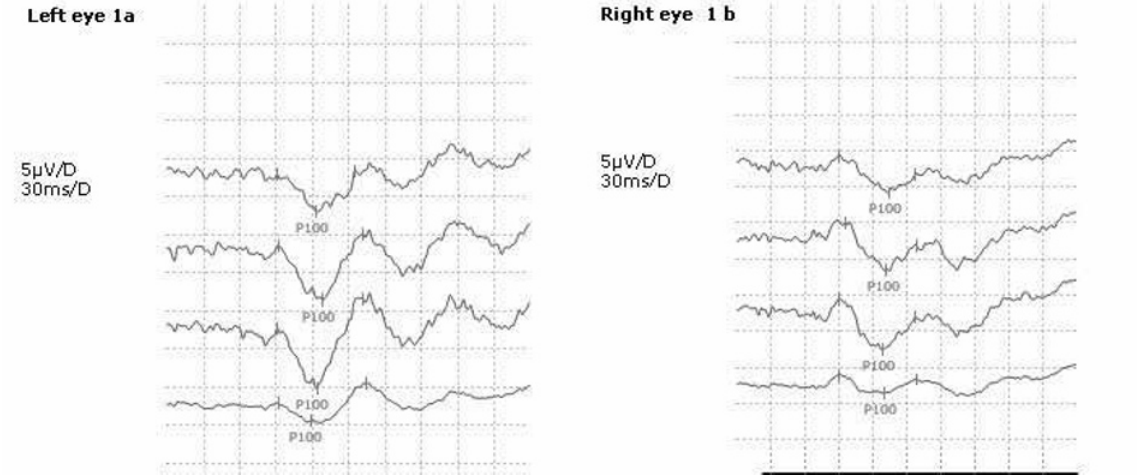
Figure 1. Pattern of visual evoked potentials (VEPs) by monocular stimulation of the left (1a) and right (1b) eye in case 1, treated with amiodar- one 200 mg daily for 46 months. The P component of the pattern VEPs had bilateral prolonged latency as to controls (normal less 100 than 110 msec). The visual acuity was 20/20 in both eyes without ophthalmoscopic and fluorescein angiographic abnormalities. The P latency recovered to normal 21 months after amiodarone